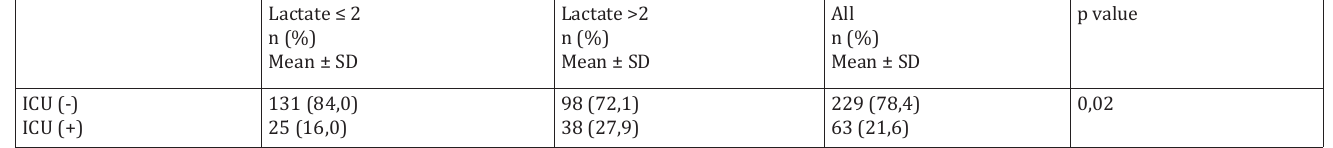
Comparison of the distribution of patients who are grouped according to lactate levels in terms of intensive care unit requirement